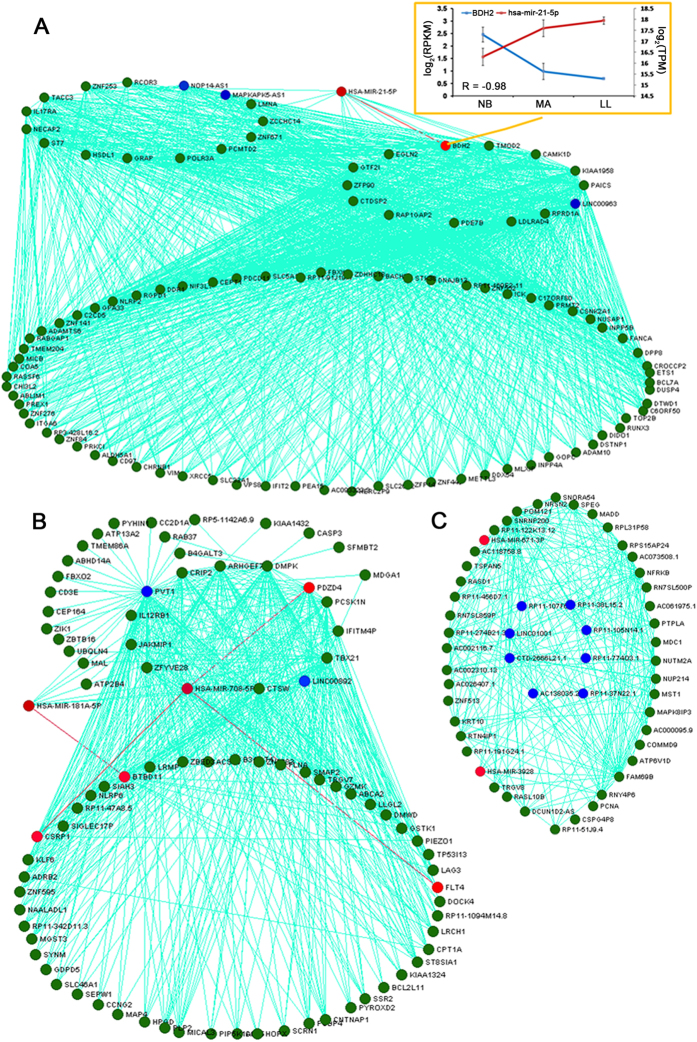
Visualization of the networks of selected modules associated with the aging process.Totals of 100 genes in the blue module, 88 in the turquoise module and 53 in the dark orange module are depicted in networks (A,B and C) respectively. Nodes in the network are labeled by their gene symbols. Each node is colored based on RNA type (blue representing lncRNA, red representing miRNA and green representing coding RNA). To improve network visibility, the edges (connections) have been filtered to display only those with correlation weights above 0.5 in the turquoise, 0.3 in the dark orange and 0.45 in the blue modules. The predicted target genes of miRNAs in each network are connected with red edges, of which had high coefficient of correlation between miRNA and gene expression are displayed at the blue module of the network with yellow box.